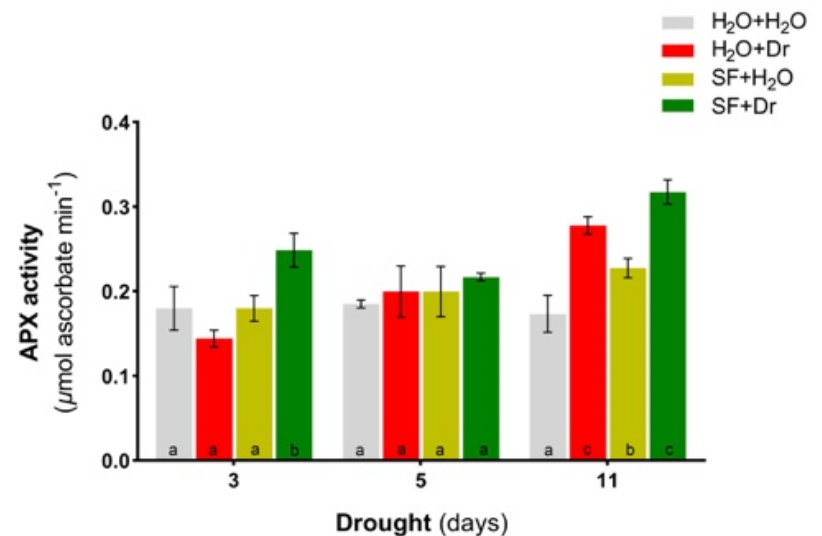
Figure 4. Ascorbate peroxidase activity in Arabidopsis leaves. Error bars denote the standard deviation (SD) of the mean. Different letters represent significant differences between the treatment means ( p < 0.05, n = 3; one-way ANOVA, Tukey’s multiple comparison test). Dr, drought stress; SF, Super Fifty.